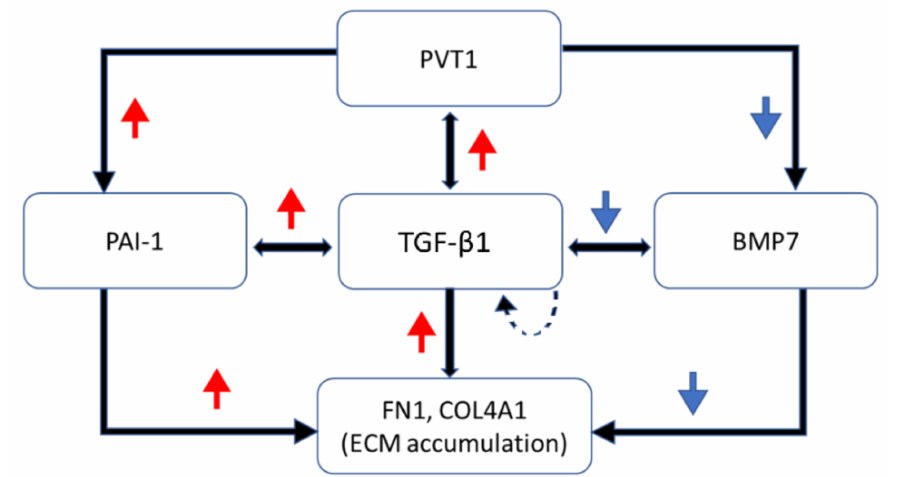
Figure 4. Potential role of PVT1 in ECM accumulation. Diabetes induces persistent hyperglycaemia in murine models. Hyperglycaemic or diabetic conditions induce an upregulation of PVT1 that results in the upregulation of ECM regulators (PAI-1 and TGF- β 1) and ECM components (FN1 and COL4A1) while downregulating BMP7 in the glomeruli. PAI-1 is the main inhibitor of ECM degrada- tion. TGF- β 1 promotes ECM accumulation by upregulating PAI-1, FN1 and COL4A1. TGF- β 1 also inhibits the anti-fibrotic actions of BMP7. PAI-1 and TGF- β 1 regulate each other to simultaneously sustain the excessive ECM accumulation. In addition, the autocrine action of TGF- β 1 to stimulate its own production further promotes its effects on ECM accumulation. PVT1 (Plasmacytoma vari- ant translocation 1); TGF- β 1 (Transforming growth factor beta 1); PAI-1 (Plasminogen activator inhibitor-1); FN1 (Fibronectin 1); COL4A1 (Collagen type IV alpha 1); BMP7 (Bone morphogenetic protein 7); red upward arrow represents a stimulatory response, blue downward arrow represents an inhibitory